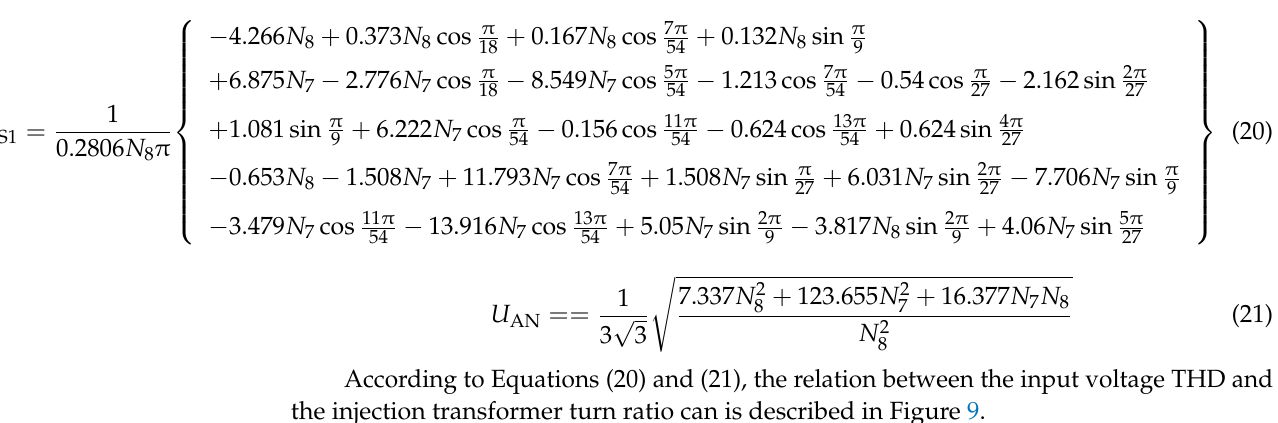
Table 1. Expressions of Voltage u AN with the harmonic suppression method.